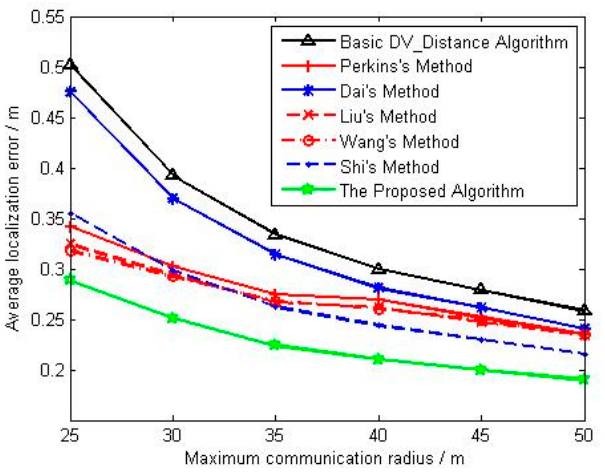
Figure 9. The change curve of average localization error with maximum communication radius.